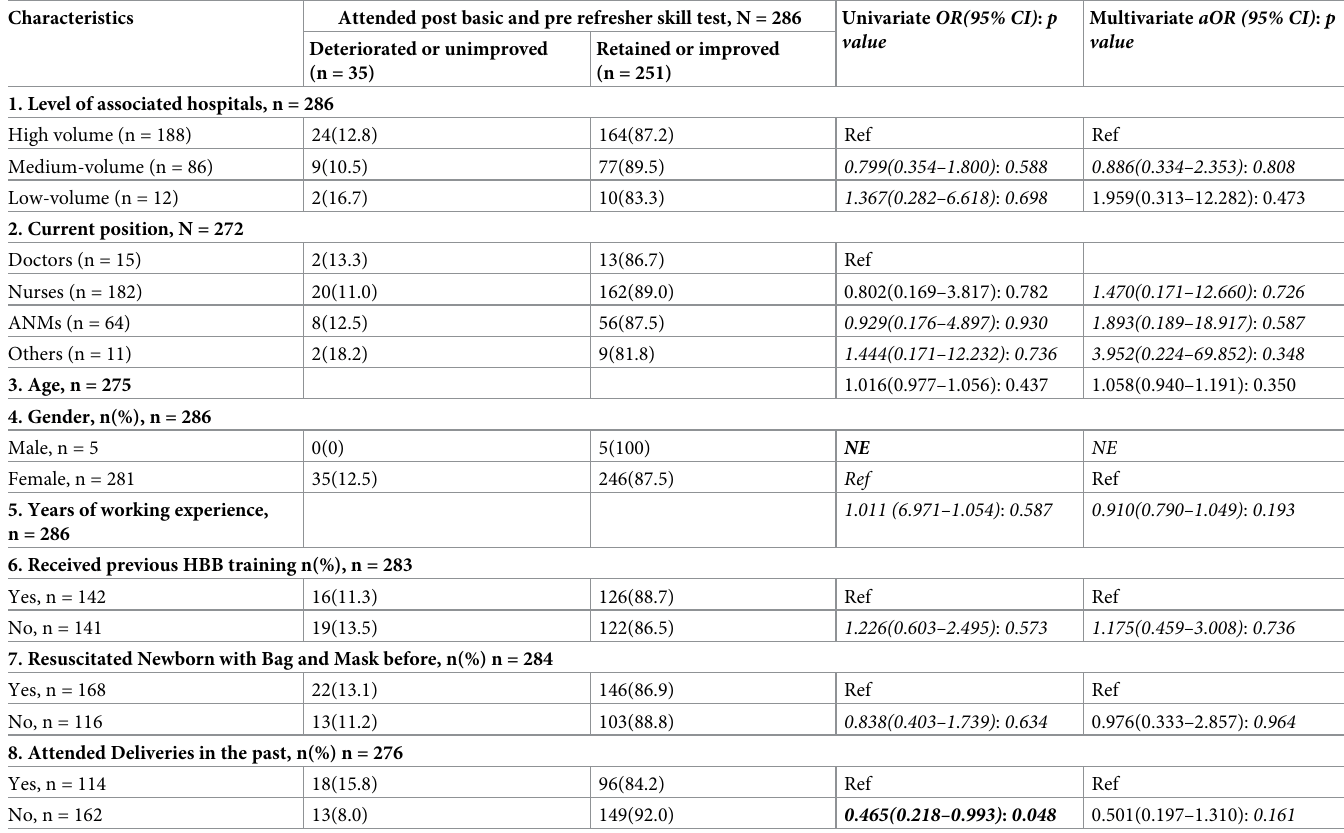
Table 5. Factors associated with deterioration of skills (post-basic vs